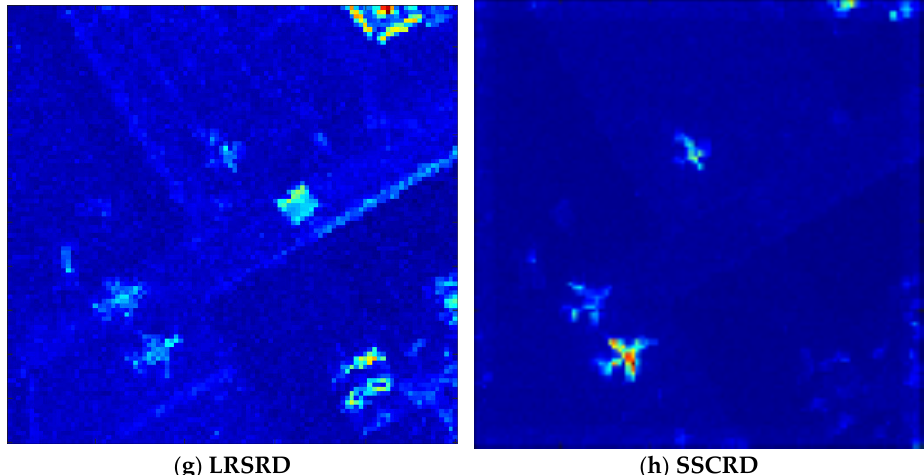
Figure 4. Color detection maps for San Diego-II image with dual-window sizes (9,13). ( a ) False color image; ( b ) ground-truth map; ( c ) over-segmentation; ( d ) label map P; ( e ) the detection result of CRD; ( f ) the detection result of CRBORAD; ( g ) the detection result of LRSRD; ( h ) the detection result of SSCRD.